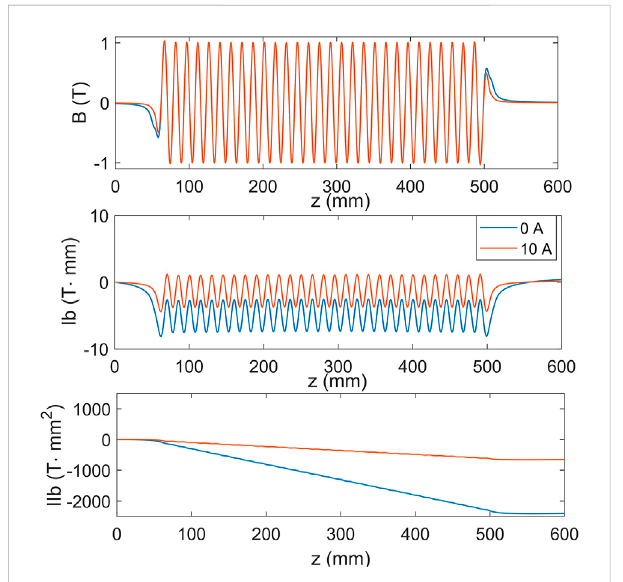
FIGURE 2 Magnetic fi eld on the axis (top) and the corresponding fi rst integral curves (middle) and second integral curves (bottom) with 0 A and 10 A correction currents, respectively, for a 0.5-m-long SCU model.